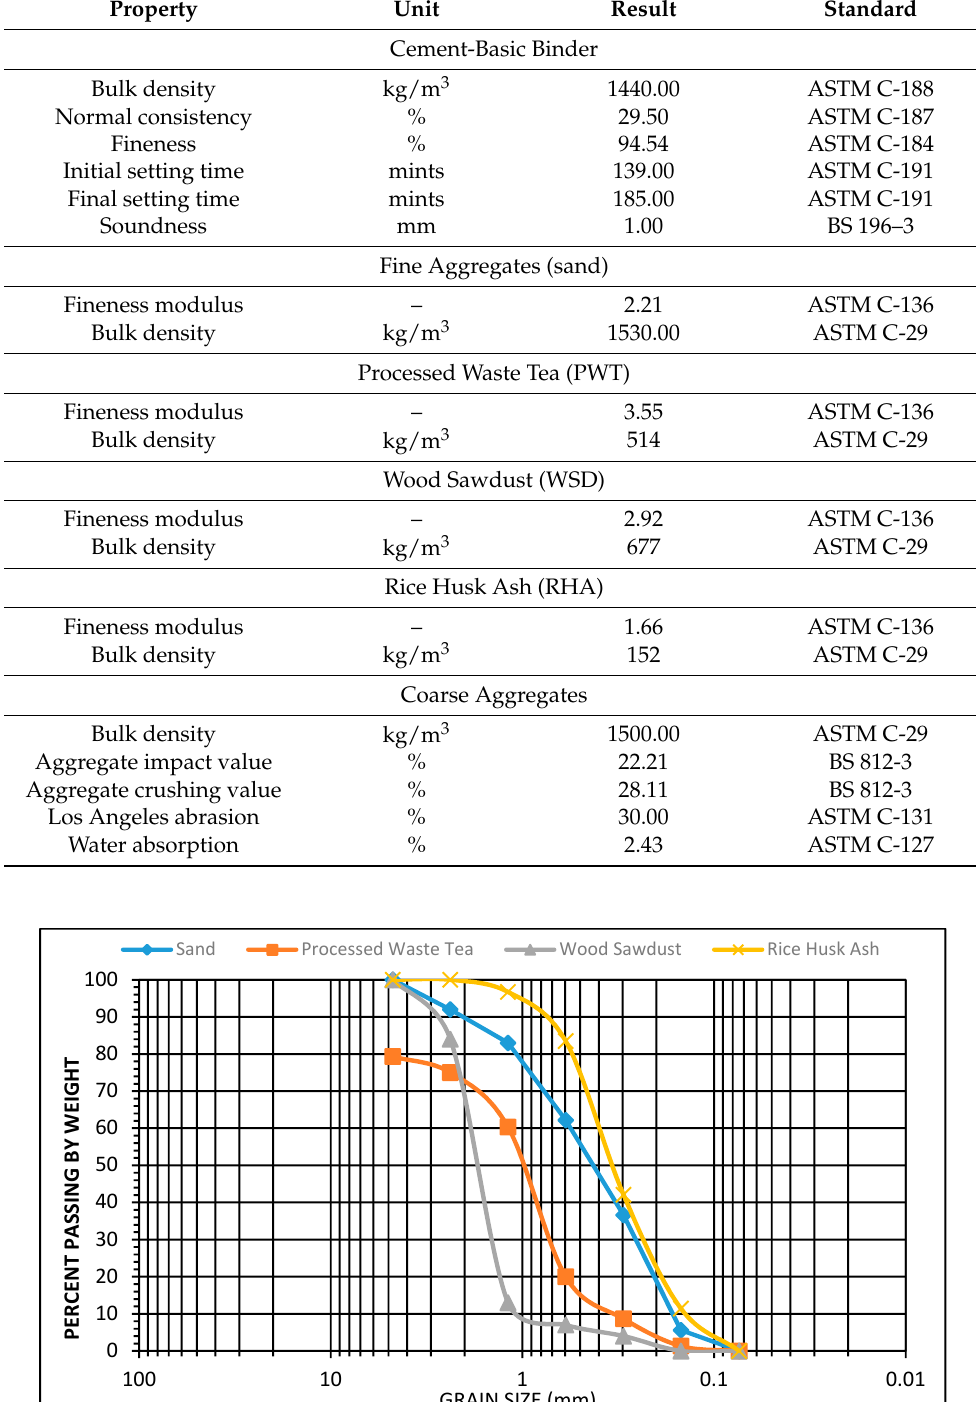
Figure 2. Coarse aggregate sieve analysis. 2.2. Waste Materials A total of three waste materials, rice husk ash (RHA), wood sawdust (WSD), pro- cesses waste tea (PWT) utilized in this study for the development of sustainable concrete. All materials obtained were of (waste) form, and the materials were utilized as a fine ag- gregate. The wood sawdust was generated because of the sawing of woods, the processed waste tea generated later the preparation of tea, and the rice husk ash obtained after the burning of rice husk at an elevated temperature around 700 °C. The physical properties of these waste materials are shown in Table 2.